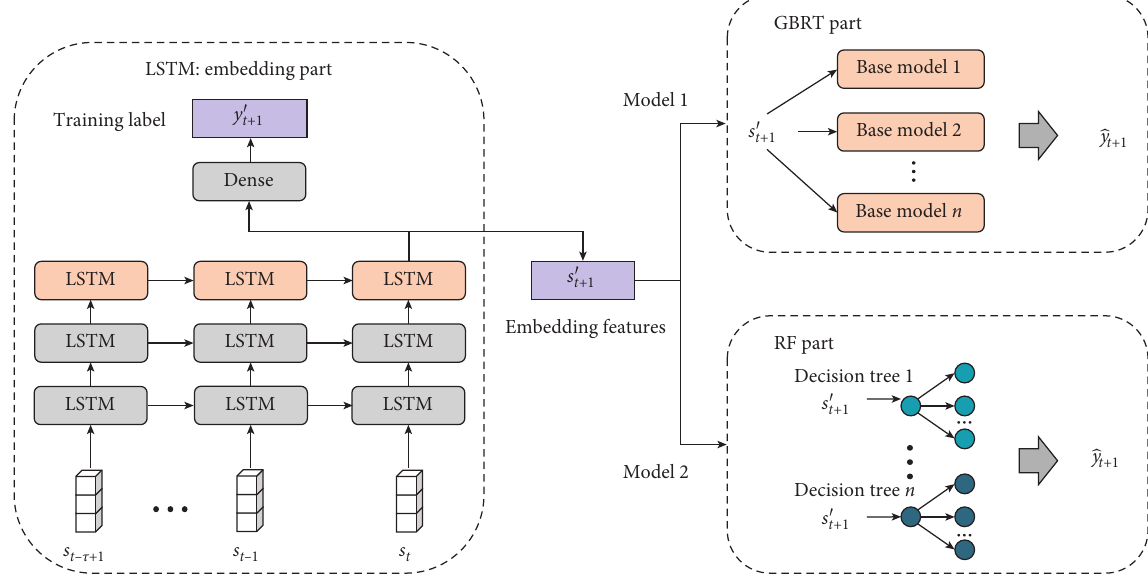
Figure 4: Structure diagram of LSTM-EL